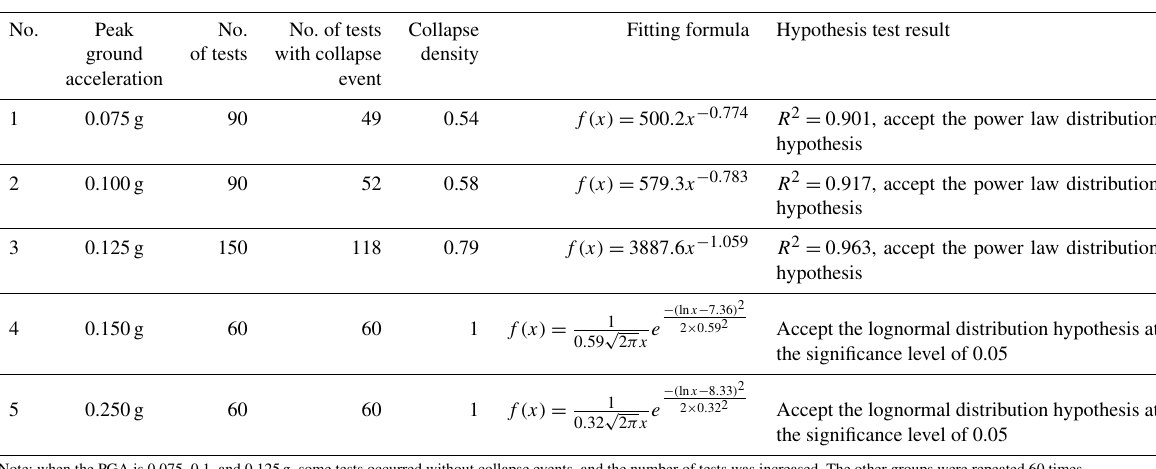
Figure 6. Schematic diagram of the shaking table experimental setup. Table 5. Statistical results of sandpile tests.